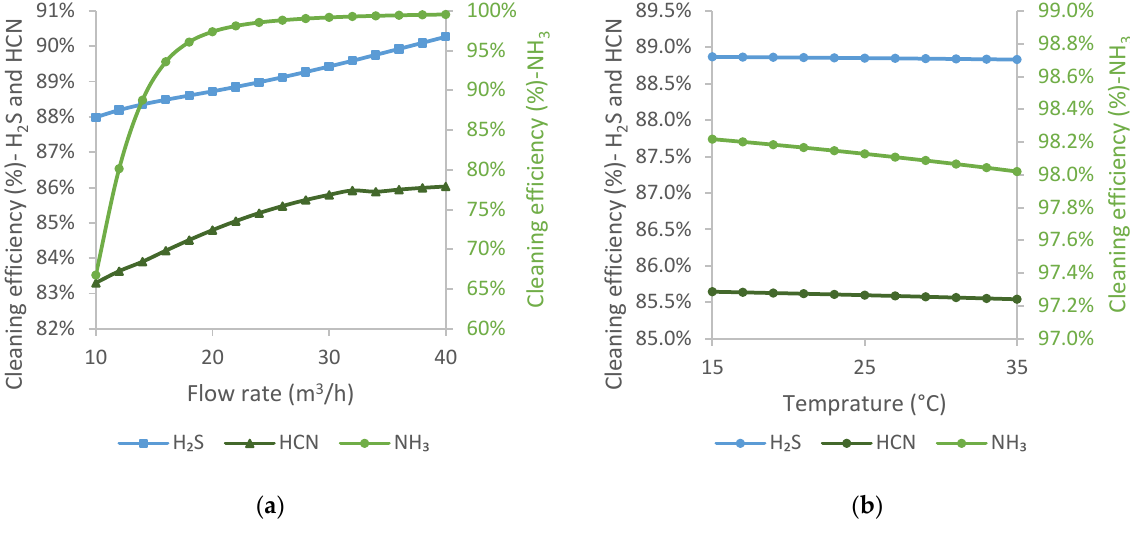
Figure 7. Effect of flow rate ( a ) and temperature ( b ) of stripped water.